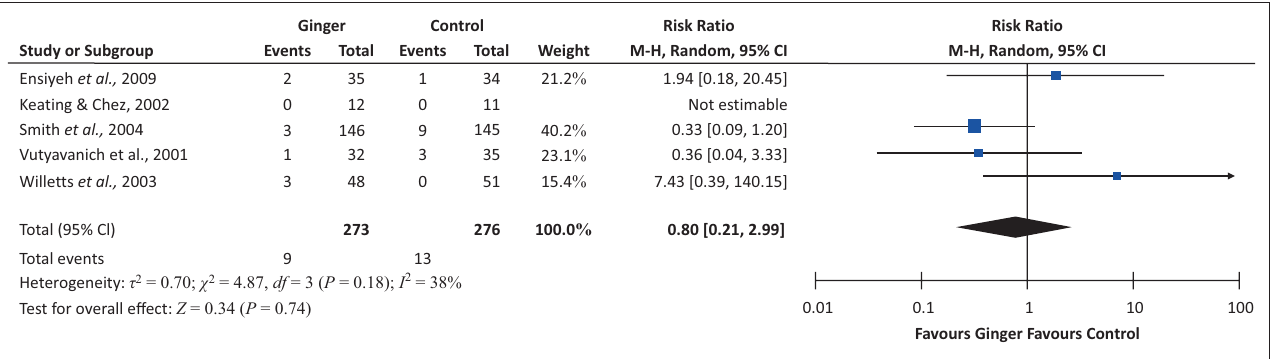
FIGURE 2: Incidence of caesarean section for ingestion of ginger.